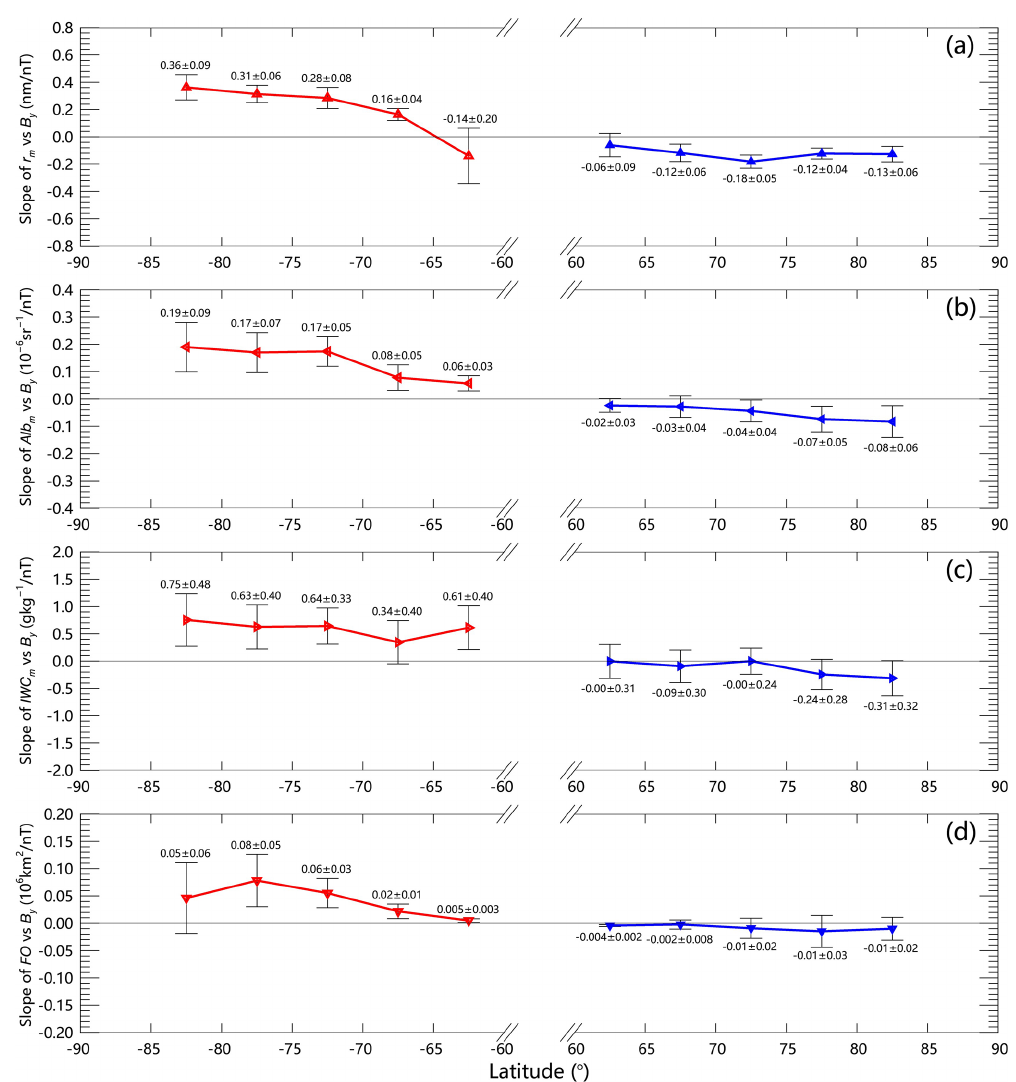
Figure 6. Slope of the anomaly of r m , Alb m and IWC m versus IMF B y at different latitude bands, with red and blue lines representing the mean slope and error bars illustrating the standard deviation of the mean for the SH and NH,